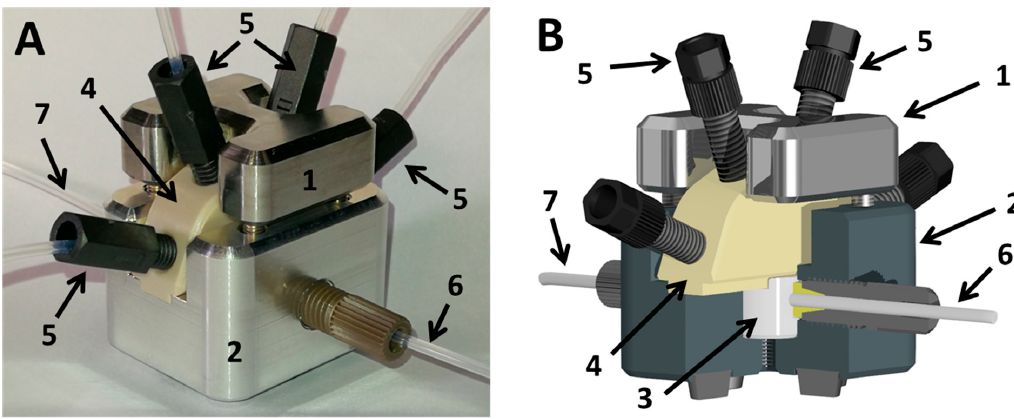
Figure 6. ( A ) Droplet generator (Figure 3B); ( B ) scheme of the droplet generator with sectional cut.